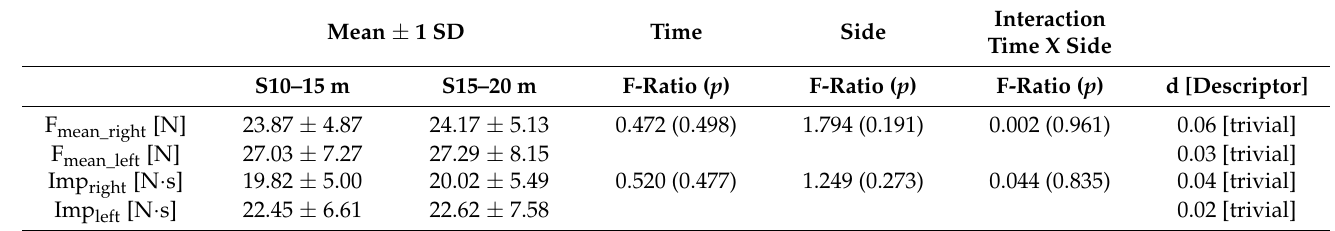
Table 1. Descriptive data (mean ± one standard deviation—1SD) of the propulsive force generated by hand in each section. It also presents the time effect (arm-pull difference between sections), side effect (difference between the propulsive force generated by both hands), and the respective interaction.